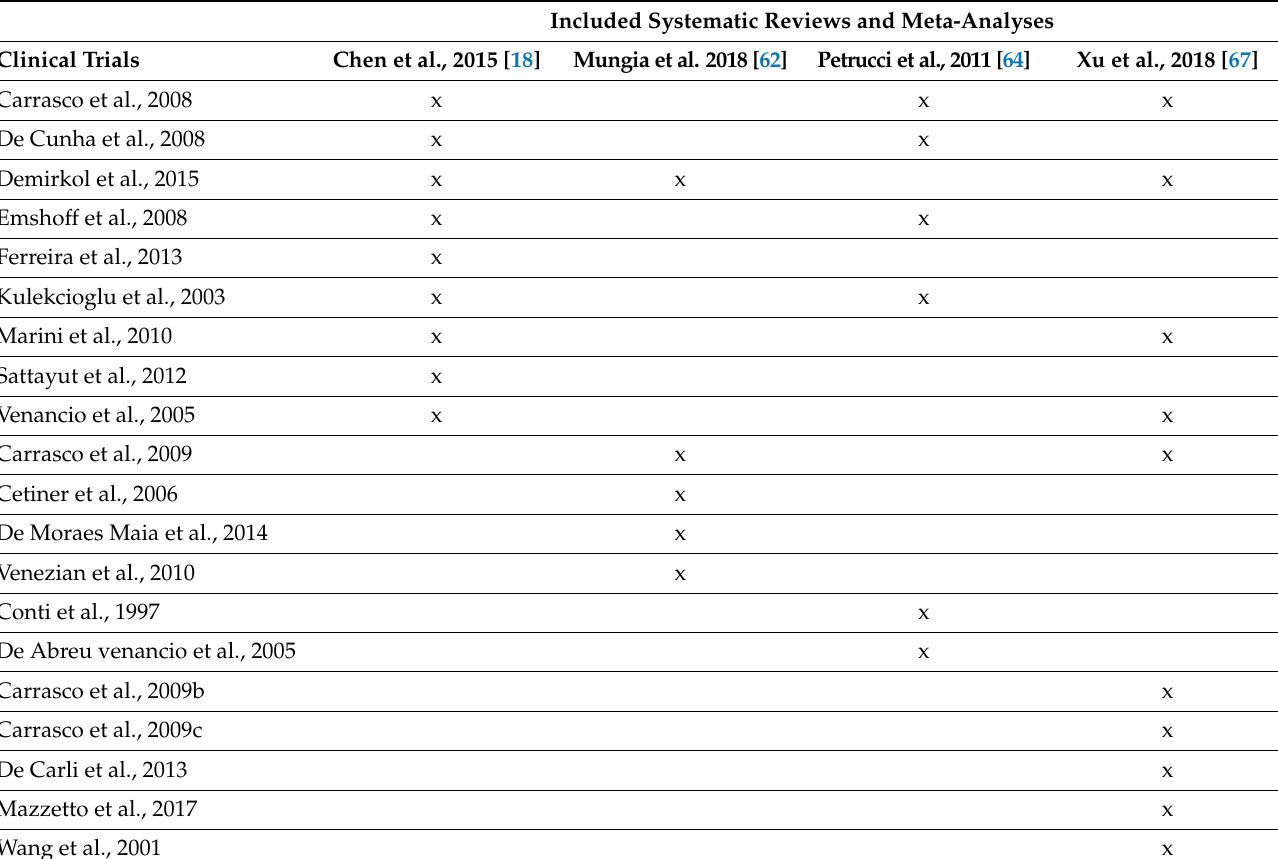
Table A6. Overlap of clinical trials of the MMA of LLLT interventions on pain